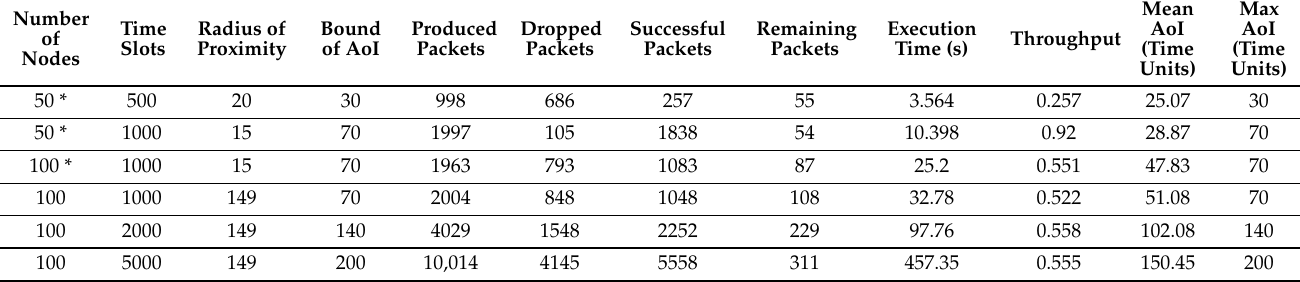
Table 3. Initial results for Modified-near-v1.